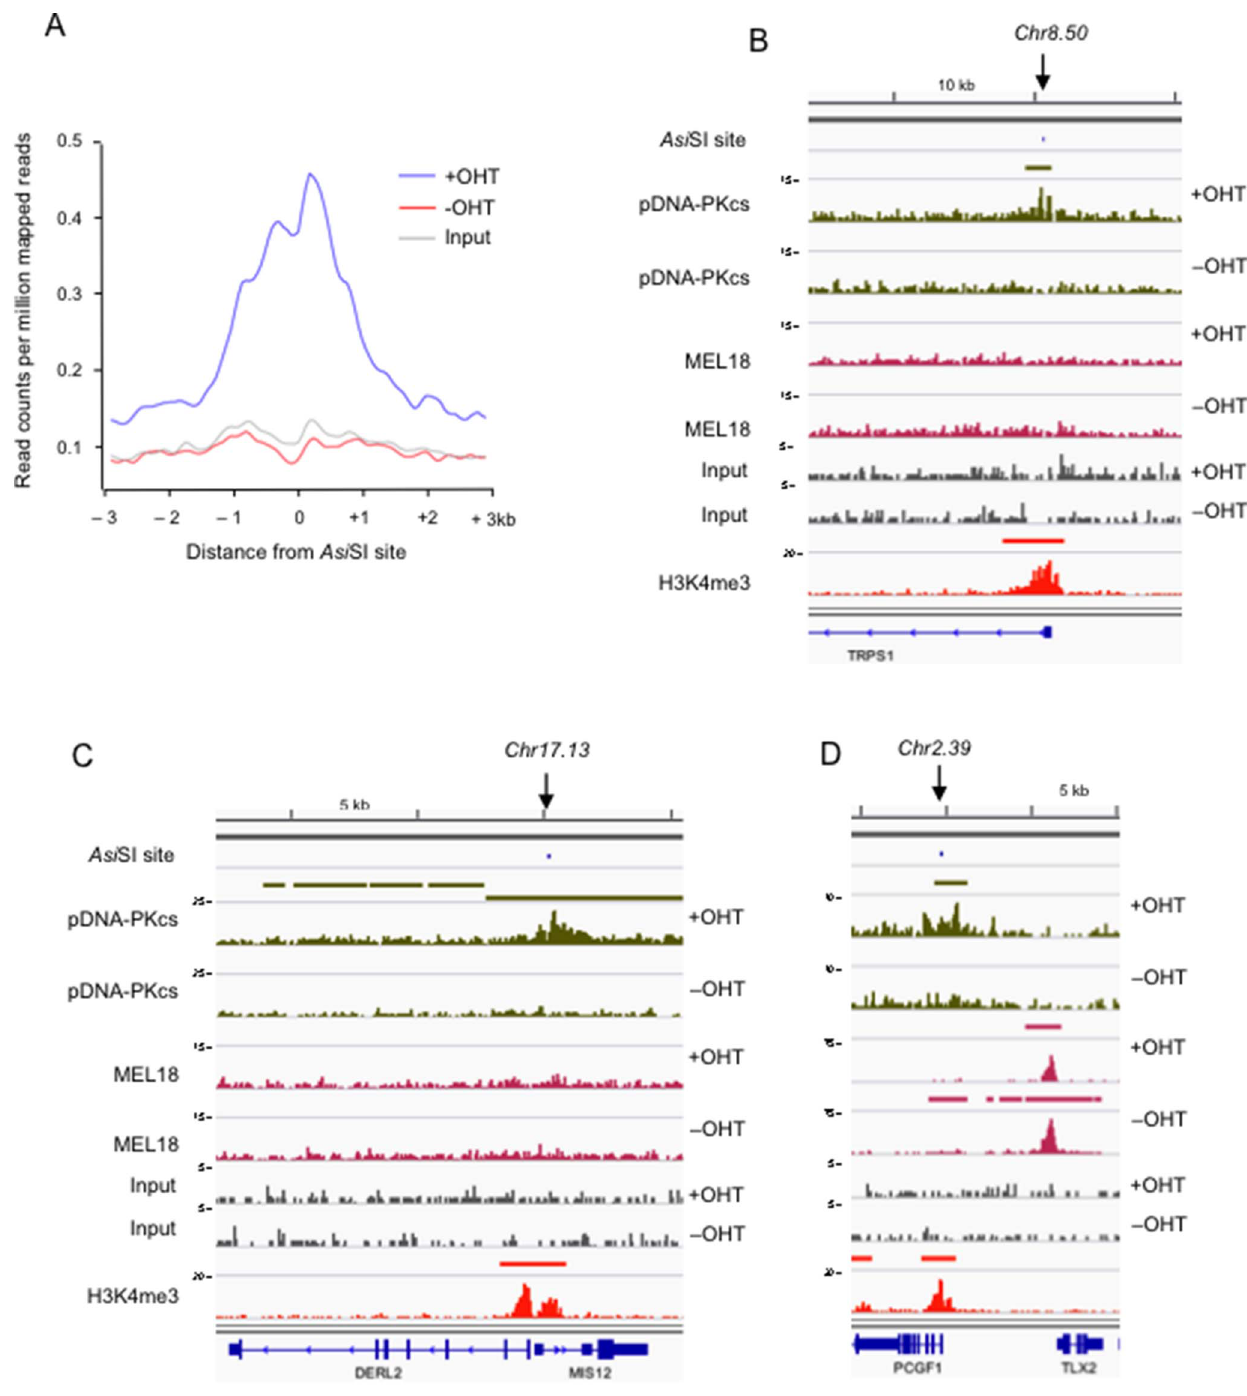
Figure 5. ChIP-seq profiles of pDNA-PKcs and PRC1 binding at Asi SI sites. A . The graph plots the read-count per million mapped reads for pDNA-PKcs binding in OHT treated (blue) and untreated (red) cells with input in grey at the 108 Asi SI sites listed in Table S3, compiled using ngsplot (https://code.google.com/p/ngsplot/). B, C and D show examples of the DNA sequence tag densities following ChIP-seq with the pDNA-PKcs and MEL18 antibodies in Asi SI:ER-transduced Hs68 cells, before and after addition of OHT, as indicated. Input refers to parallel analyses of the chromatin before immunoprecipitation. The maximum coverage for each track is shown on the left of the screen shot and a size bar is included above. The locations of the Chr8.50, Chr17.13 and Chr2.39 Asi SI sites are identified by a downward arrow and the genomic organization of adjacent RefSeq loci is shown below. The H3K4me3 track refers to genome-wide enrichment of H3K4me3 in the Hs68 strain of HFs from a previously deposited dataset (GEO accession number 40740).